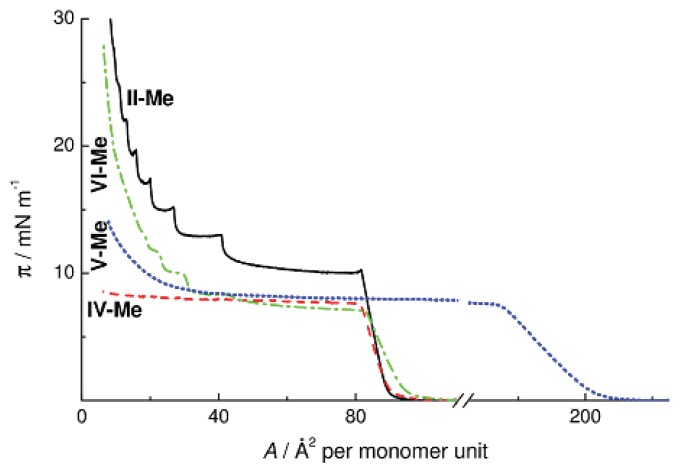
π-A isotherms of CL POS II-Me and CL PMCS IV–VI on water at 20 °C.